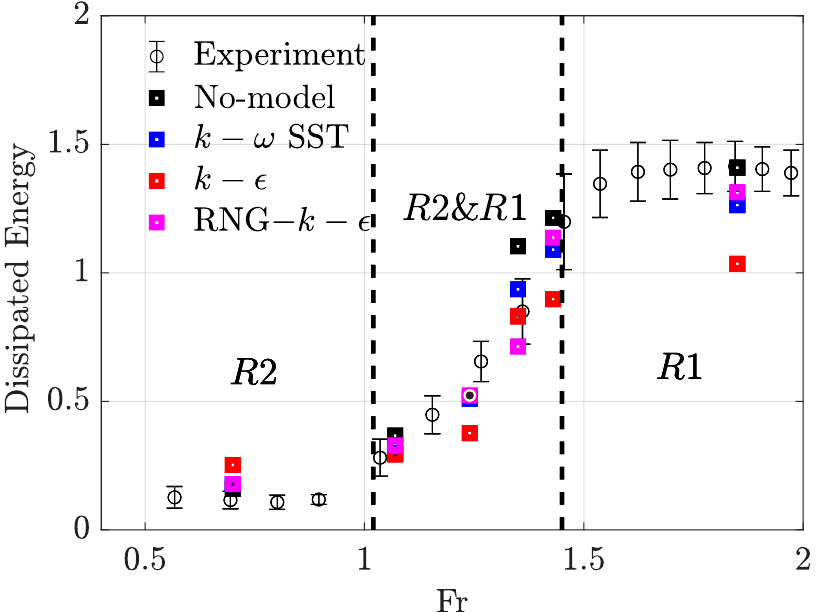
Figure 6. The normalised dissipated energy as a function of Fr numbers computed by different turbulent modelling and compared with experimental measurements [59].